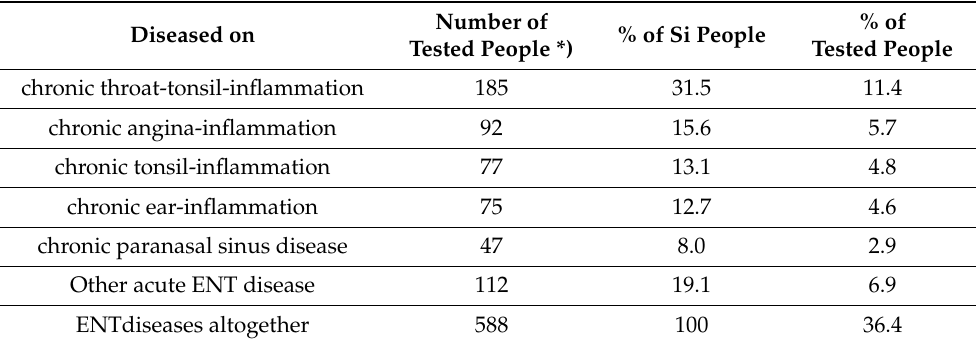
Table 3. ENT (Ear-Nose-Throat) diseases of the inhabitants of the Rayon Kazalinsk, District Kyzy- lorda, Kazakhstan, 1989 *). Diseased